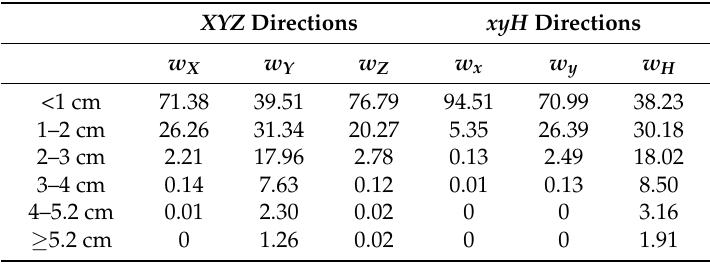
Table 2. Statistics of misclosures of the spatial GNSS monitoring network (%).